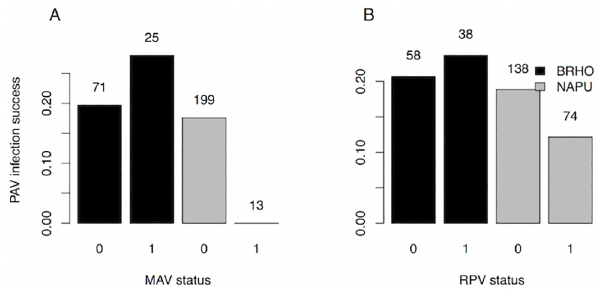
Fig 1. PAV inoculation success versus plant species and MAV (A) and RPV (B) infection status. Inoculation success is equal to the fraction of plants inoculated with PAV that tested positive for PAV in the ELISA. MAV status is zero for plants uninfected with MAV and one for plants infected with MAV, and likewise for RPV. Black bars are Bromus hordeaceus and gray bars are Nassella pulchra . Numbers above the bars indicate the number of plants in each group.